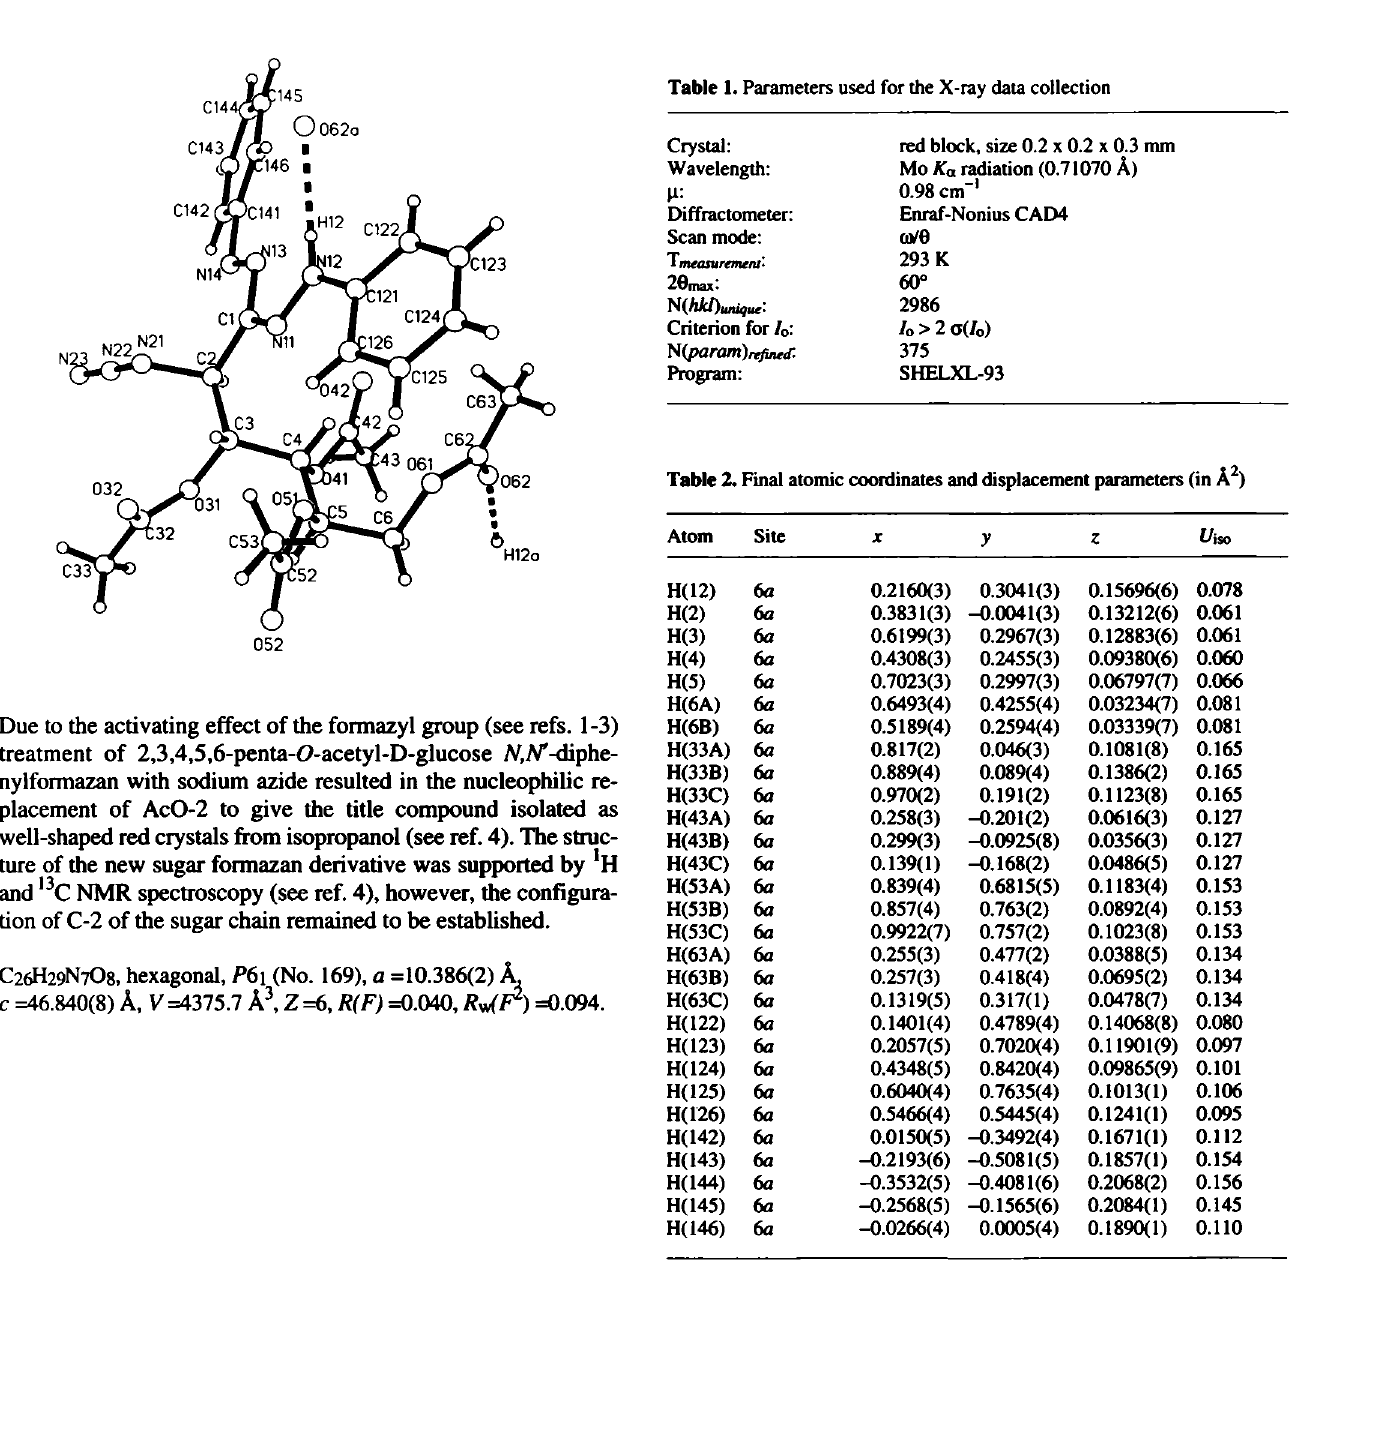
Table 1. Parameters used for the X-ray data collection